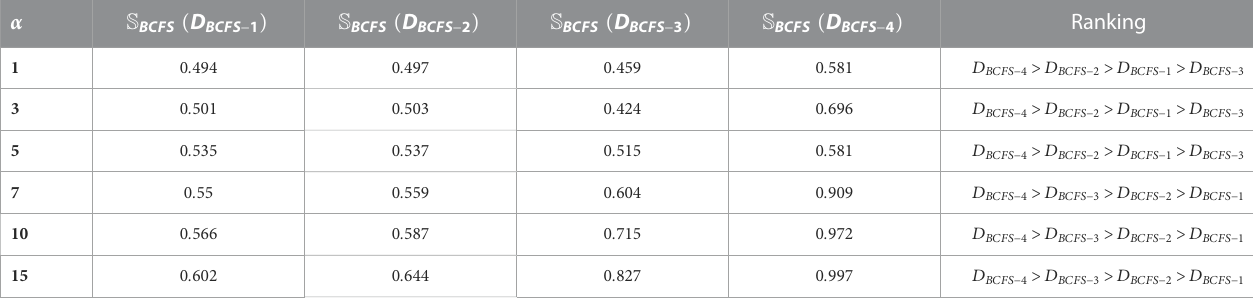
TABLE 7 Score values and ranking order for various values of α using the BCFPDA operator.